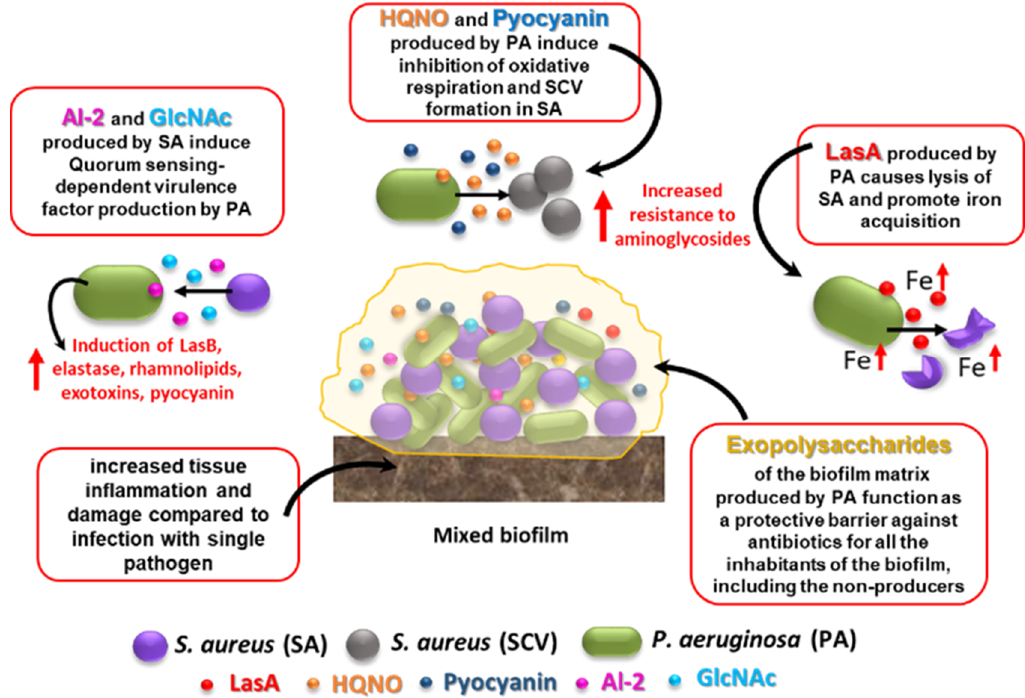
Figure 1. Effects of S. aureus–P. aeruginosa mixed infection on resistance and virulence as compared to single-species biofilms. Some of the best characterized interactions that occur between the two species in mixed biofilms are shown. See text for details. HQNO: 4-Hydroxy-2-Heptylquinoline N-Oxide; SCV: small colony variant; AI-2: autoinducer 2; GlcNAc: N-acetyl glucosamine, a component of bacterial peptidoglycan.